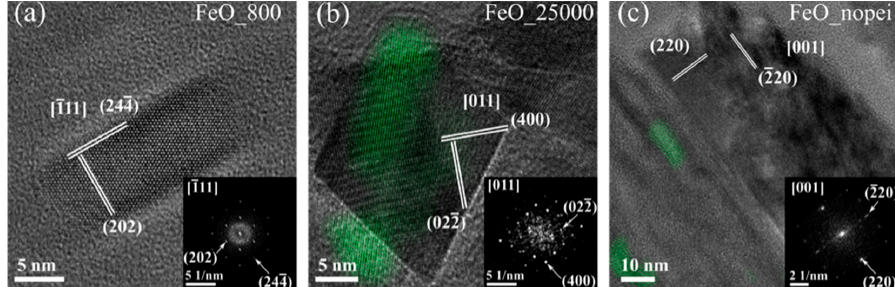
Figure 4. HRTEM images and corresponding 2D-FFTs of representative NPs from the FeO_800 ( a ); FeO_25000 ( b ); FeO_nopei ( c ) samples. Full structural characterization of the magnetite phase is provided in each inset, while the false-colored green areas in the main ( b , c ) panels indicate the